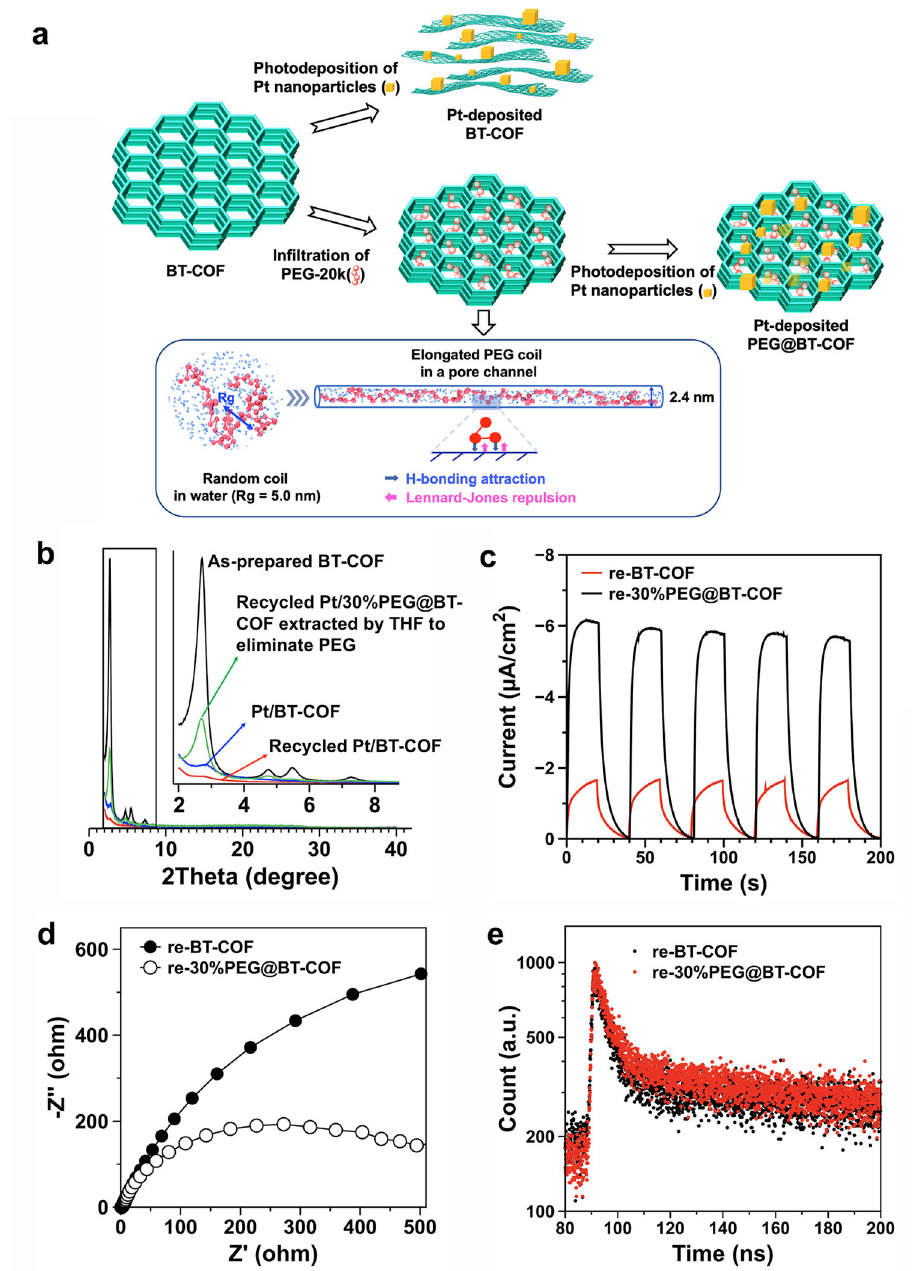
Fig. 4 PXRD patterns, proposed mechanism, and photophysical measurements. a Illustration of structural transformation of COF and PEG@COF during the deposition of Pt cocatalyst. PEG conformations in water and in a pore channel (2.4 nm) are simulated by the dissipative particle dynamics (DPD) method in the canonical ensemble, respectively. According to the coarse-graining model, harmonic-bond-linked DPD beads and individual beads are applied to model PEG and water, respectively. b PXRD patterns of the as-prepared BT-COF (black curve), the Pt-deposited BT-COF before (blue curve), and after (red curve) 48-h cycling and the recycled 30%PEG@BT-COF (green curve) after 48-h photocatalysis, of which the loaded PEG was washed off by THF prior to the PXRD measurement. c Transient photocurrent responses, d Nyquist plots, and e TCSPC measured fl uorescence decay pro fi les of the re- BT-COF and re-30%PEG@BT-COF obtained after 48-h photocatalysis,